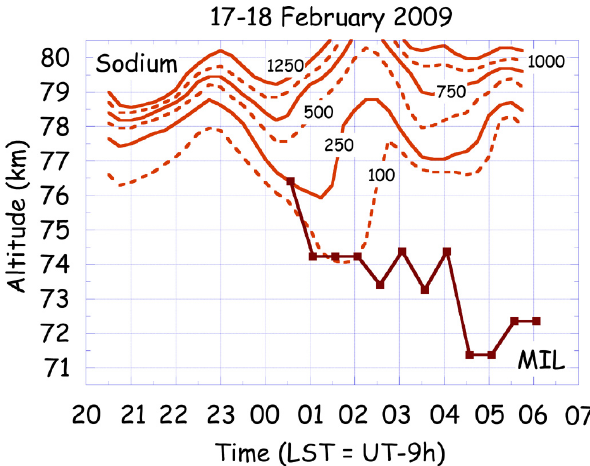
and dashed lines) and mesospheric inversion layer peak (solid line with closed square) as a function of time measured by resonance and Rayleigh lidars respectively at Chatanika, Alaska on the night of 17–18 February 2009. The sodium concentration contours are labeled in cm − 3